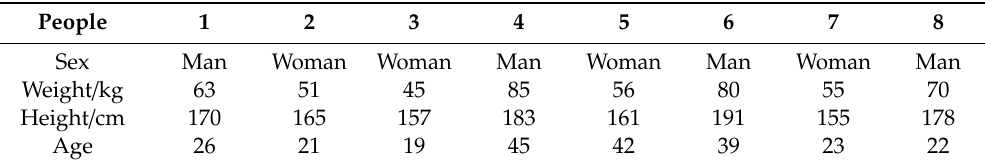
Table 8. Basic table of laboratory personnel.